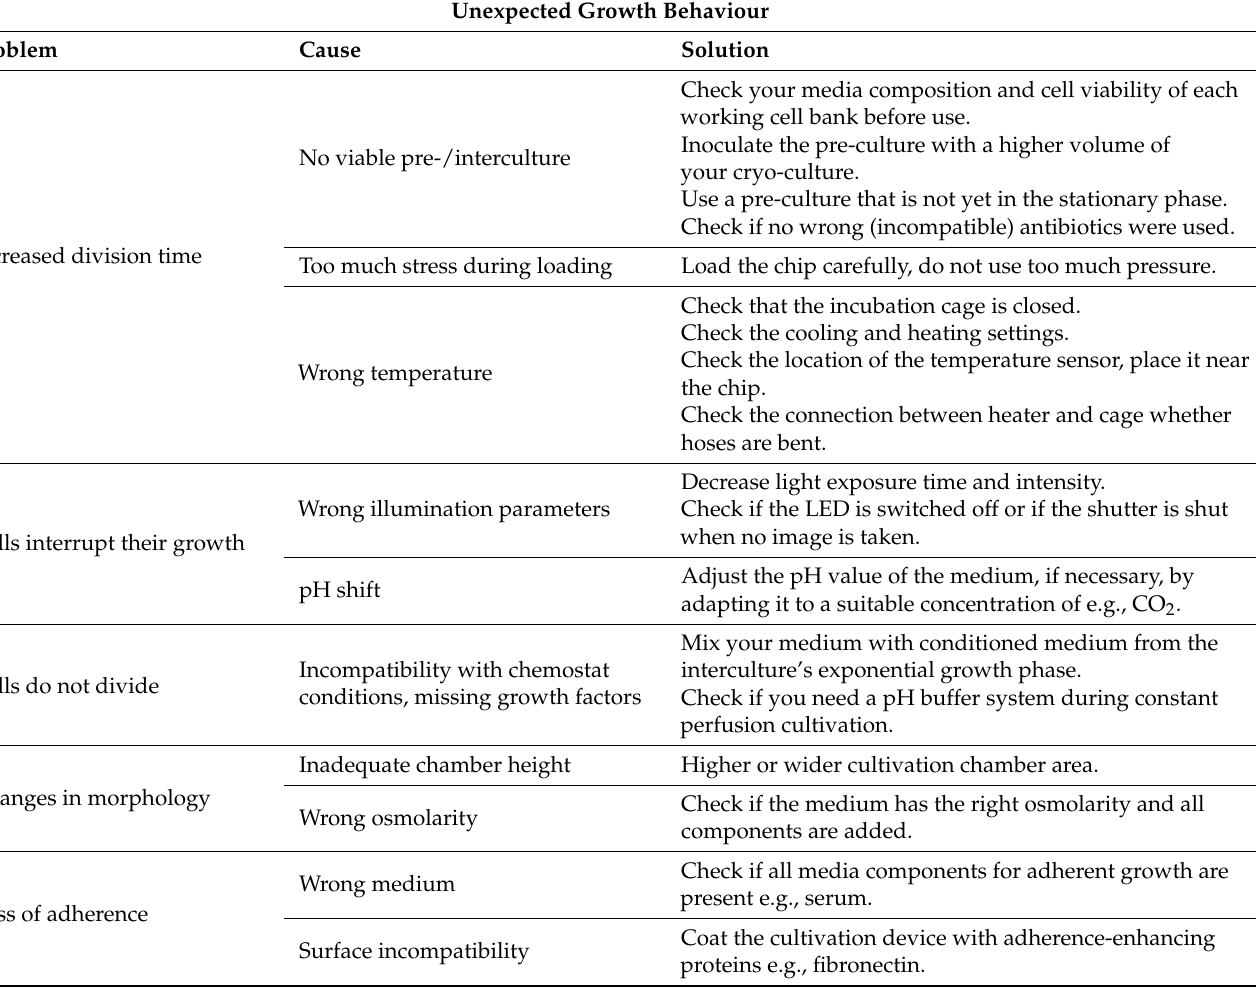
Table 9. Listed are the most frequently occurring challenges concerning unexpected growth behaviour with their respective cause and a suggested